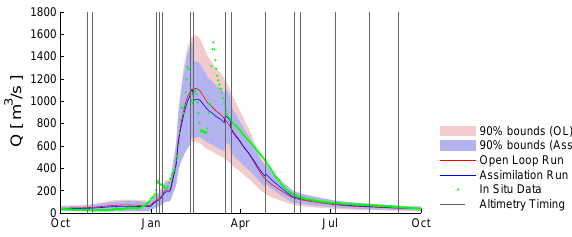
Fig. 5. Timing of altimetry measurements in watershed 2 and assim- ilation performance at reach 17 from October 2006 to October